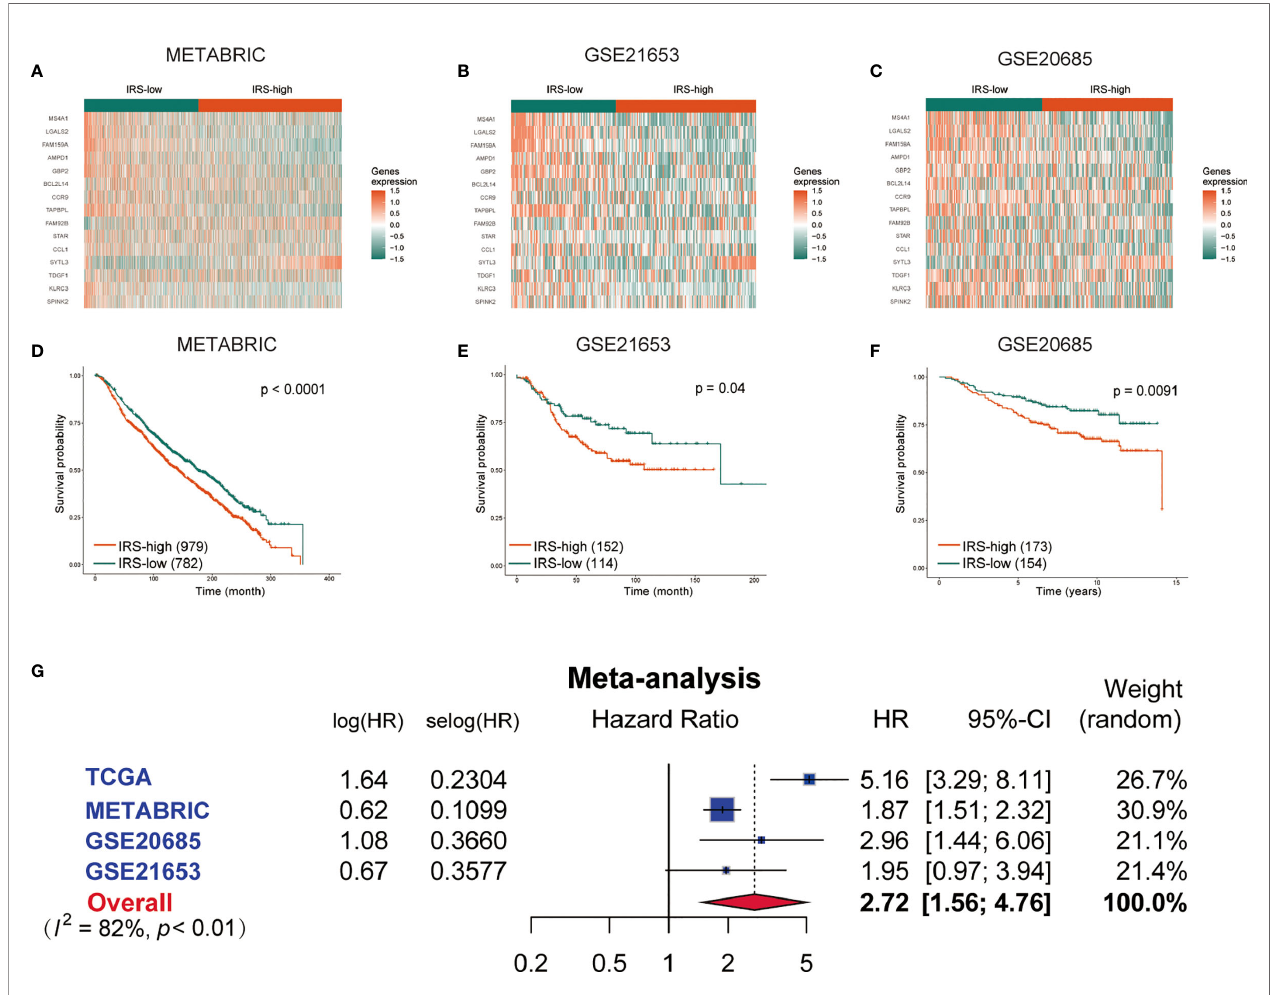
FIGURE 5 | Validation of the gene signature in the external validation sets. The expression heatmap of the 15 immune-related prognostic genes between the high- and low-IRS groups in the METABRIC (A) , GSE21653 (B) and GSE20685 (C) cohorts. Kaplan-Meier curves for the OS of patients in the high-risk group and low-risk group in the METABRIC (D) , GSE21653 (E) and GSE20685 (F) cohorts. (G) Meta-analysis of the TCGA training set and 3 external validation sets. METABRIC, Molecular Taxonomy of Breast Cancer International Consortium; GSE, gene expression omnibus series; IRS, immune-related risk score; High-IRS, high immune- related risk score; Low-IRS, low immune-related risk